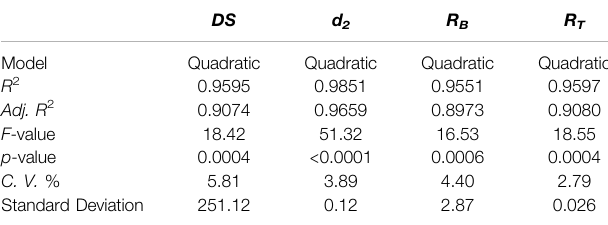
TABLE 9 | Analysis of variance